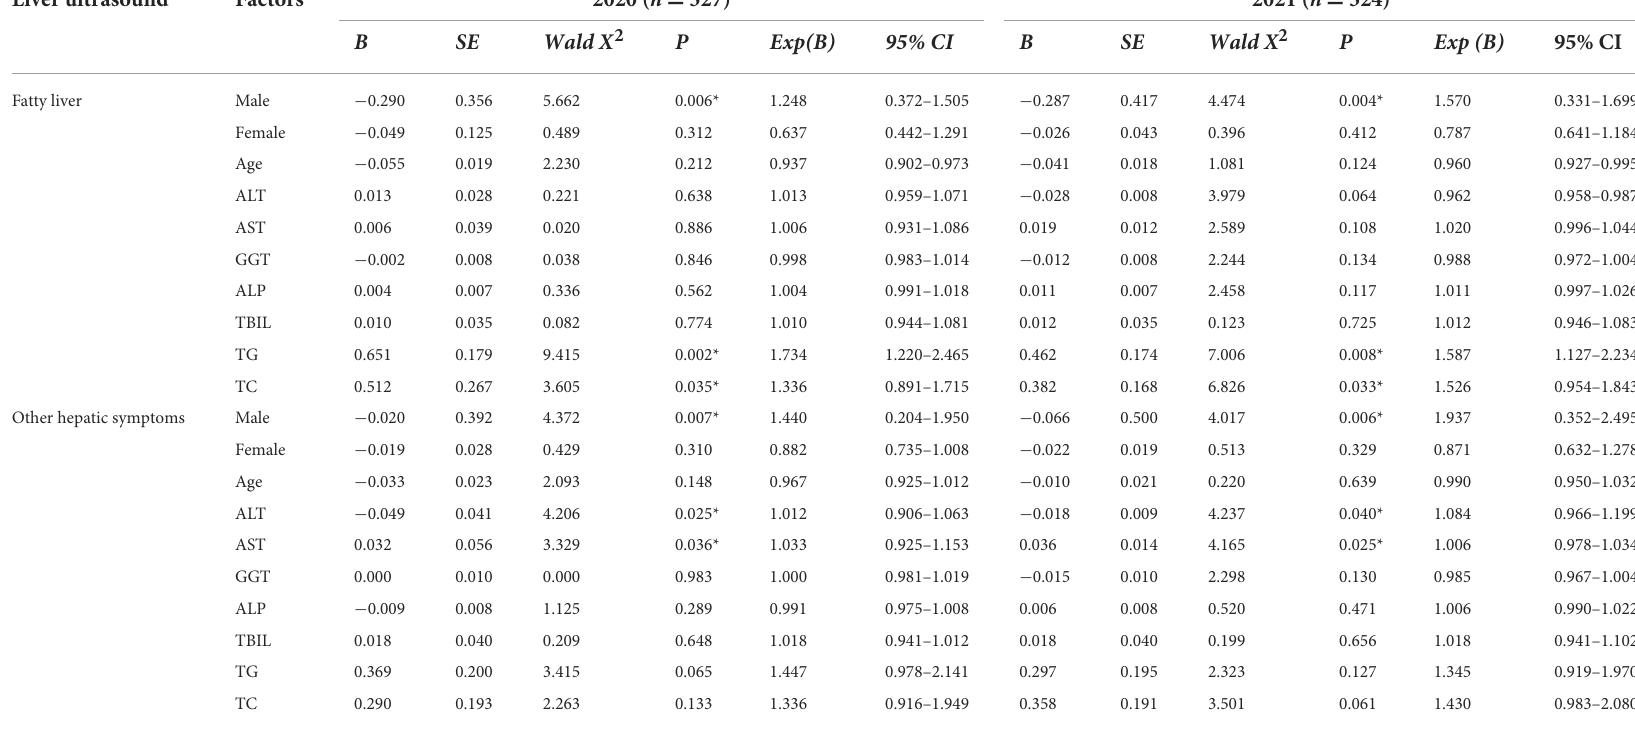
TABLE 9 Results of multiple linear regression analysis for physical exam data in Z in 2020 and